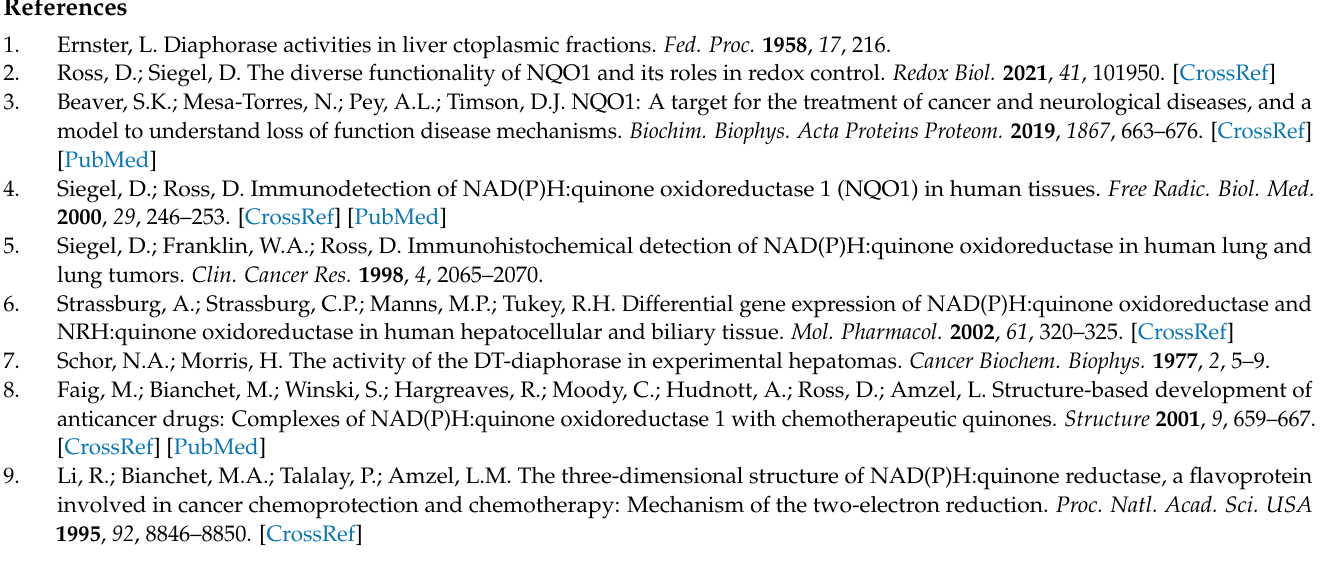
Figure S3: Spectra of 2,6,7-trichloro-5,8-chinolinodion 7 ; Figure S4: The optimized structure of 5,8- quinolinedione compounds 3 and 6–7 ; Figure S5: The 1 H- 13 C HSQC spectrum (600 MHz, CDCl 3 ) of compound 3 ; Figure S6: The 1 H- 13 C HMBC spectrum (600 MHz, CDCl 3 ) of compound 3 ; Table S1: Interaction of compounds 1–3 and 6–7 with an active site of the NQO1